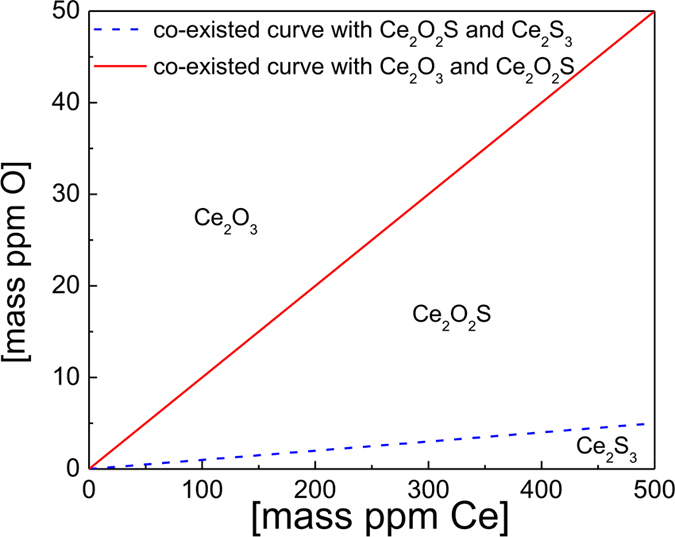
Relationship of [O] and [S] when Ce2O2S, Ce2O3, and Ce2S3 can form as stable compounds in molten iron at 1873 K.